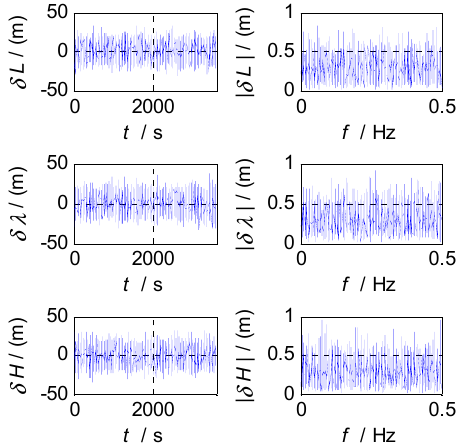
Figure 9. Position errors and frequency characteristics of GPS.